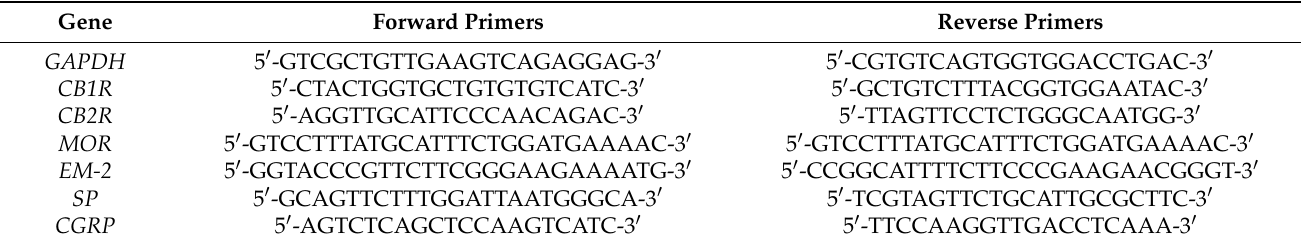
Table 1. PCR primer sequences used for RT-PCR analysis of